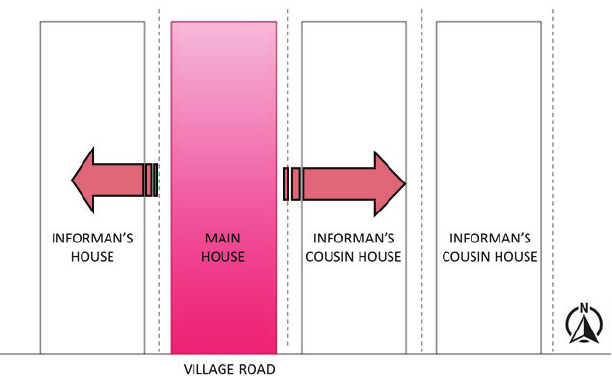
Figure 12. The shawl house form (source: Survey,